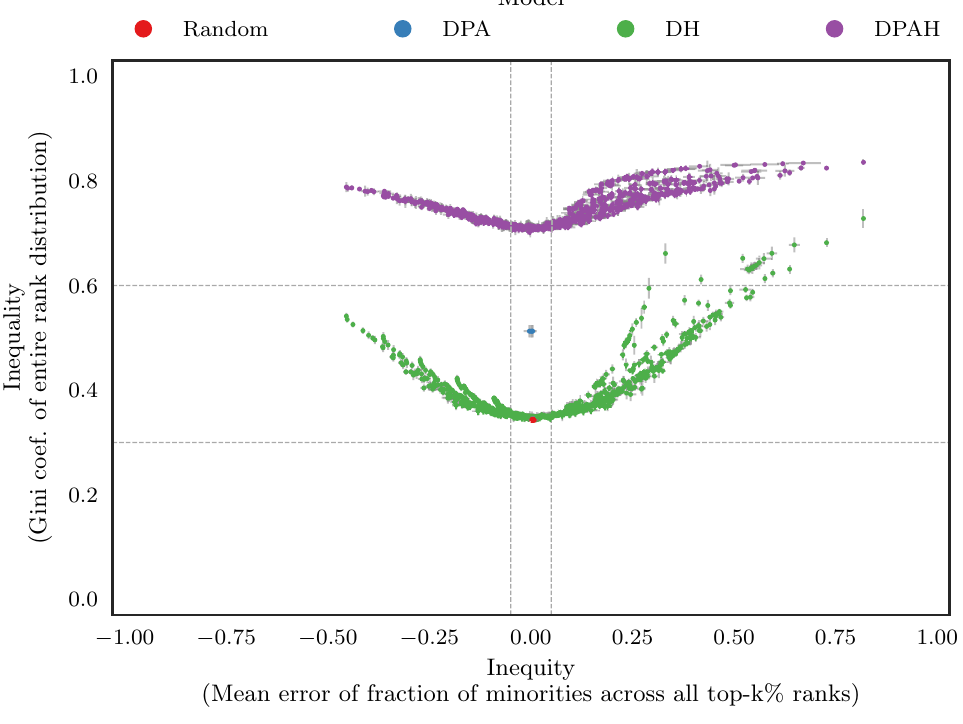
Figure 6. The effects of homophily and preferential attachment in the global disparity of PageRank. We generated directed networks using four different models of edge formation. DPA: only preferential attachment. DH: only homophily. DPAH: our proposed model that combines DPA and DH. Random: a baseline where nodes are connected randomly. We see the following patterns: (i) Homophily (DH) produces a moderate- to-high level of inequality ( 0.3 < Gini < 0.8 ), while preferential attachment (DPA) produces a consistent moderate inequality ( Gini ≈ 0.5 ). When both mechanisms are combined (DPAH), the rank inequality increases even further ( 0.7 < Gini < 0.9 ). (ii) Random and Preferential attachment (DPA) are always fair ( ME = 0 or | ME | ≤ β ), while in the cases where homophily is involved (DH and DPAH) inequity is often high ( | ME | > β ). Thus, in general preferential attachment is the main driver of inequality, while homophily influences both inequality and inequity. Vertical and horizontal error bars represent the standard deviation over 10 runs of the Gini and ME,